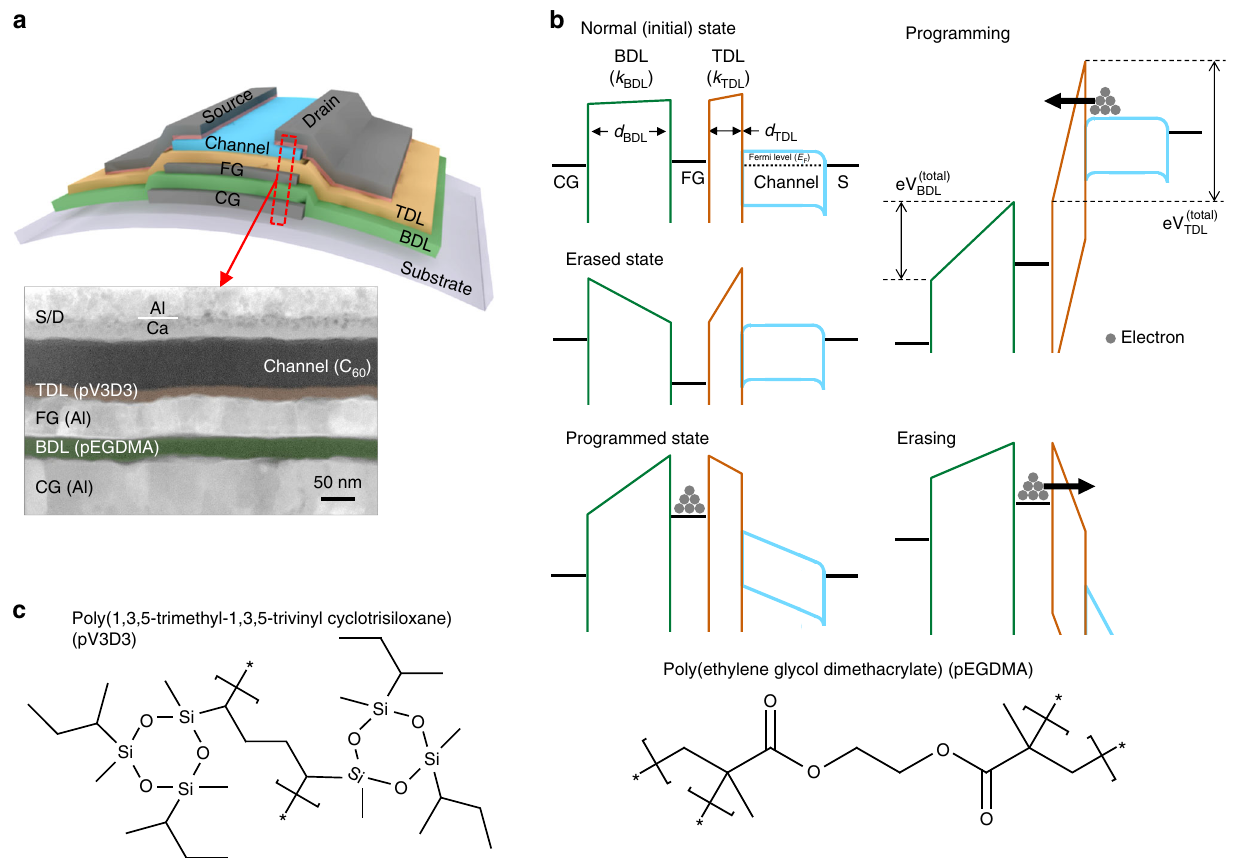
Fig. 1 Structure of thin- fi lm transistor-based organic fl ash memories and their operation mechanism. a The schematic device structure of the proposed fl ash memory and a false-color cross-sectional TEM image of the fabricated fl ash memory device. TDL, BDL, CG, FG, and S/D refer to tunneling dielectric layer, blocking dielectric layer, control gate, fl oating gate, and source/drain, respectively. b Energy band diagrams of the fl ash memory device under study for various operation regimes. The total voltages across BDL ( = V BDL (total) ) and TDL ( = V TDL (total) ) are determined by the various factors such as built-in voltages, applied V CG , and coupling ratio, V th shift due to stored or depleted charges, etc., as described in details in Supplementary Table 1. c Chemical structures of the poly(1,3,5-trimethyl-1,3,5-trivinyl cyclotrisiloxane) (pV3D3) and the poly(ethylene glycol dimethacrylate) (pEGDMA) polymers used as TDL and BDL,